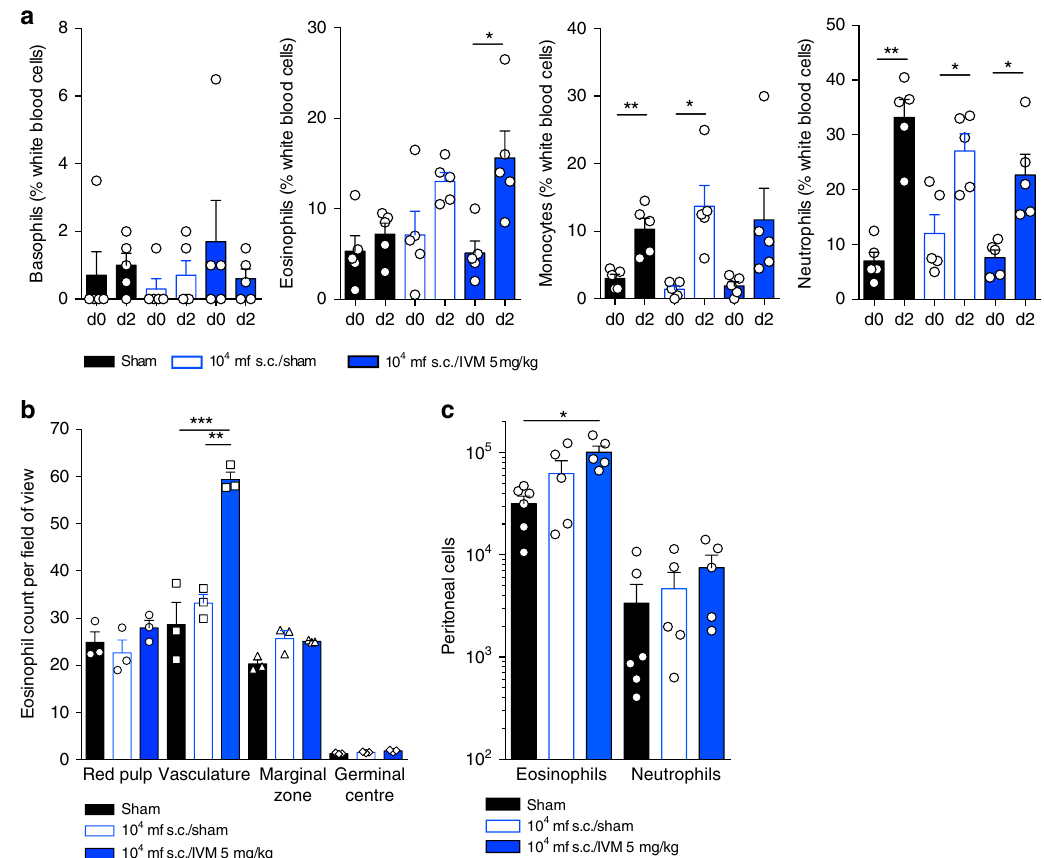
Fig. 5 Ivermectin treatment induces eosinophilia in L. loa micro fi laraemic mice. a Differential white blood cell counts determined by blood thin smear and MGG staining at baseline or 2 days post infusion with 40,000 puri fi ed L. loa mf into BALB/c mice ± prior immune-priming with s.c. inoculations of 1 × 10 4 heat-killed L. loa mf and sham or IVM 5 mg/kg treatment s.c. at the point of infusion ( n = 5 mice per group). Proportions of basophils, eosinophils, monocytes and neutrophils were enumerated per 200 leucocytes per slide. Data plotted are speci fi c cell proportions of total leucocytes (%) of individual mice and mean ± SEM. b Eosinophil counts in the red pulp, vasculature, white pulp marginal zones and germinal centres in sections of spleen 7 days post infusion with 40,000 puri fi ed L. loa mf into BALB/c mice ± prior immune-priming with s.c. inoculations of 1 × 10 4 heat-killed L. loa mf and sham or IVM 5 mg/kg treatment s.c. at the point of infusion ( n = 3 mice per group). Plotted is mean counts for 10 quadrants of 120 µ m x 200 µ m per splenic zone per mouse, and mean ± SEM per group. c Eosinophil and neutrophil enumerations within peritoneal exudate cells acquired by fl ow cytometry, 7 days post infusion with 40,000 puri fi ed L. loa mf into BALB/c mice ± prior immune-priming with s.c. inoculations of 1 × 10 4 heat-killed L. loa mf and sham or IVM 5 mg/kg treatment s.c. at the point of infusion ( n = 5 mice per group except sham group, n = 6). Plotted is individual data and mean ± SEM. Signi fi cant changes in paired data is tested by T test ( a ). Signi fi cant differences for three independent groups are determined by one-way ANOVA with Dunnett ’ s post-hoc tests ( b , c ). Signi fi cance is indicated: * p < 0.05, ** p < 0.01, *** p <